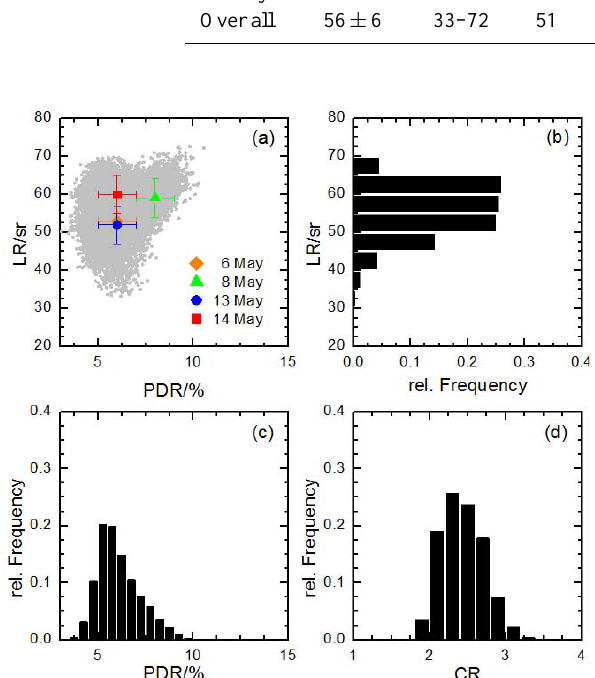
Fig. 8. (a) Scatterplot of lidar ratio (LR) vs. particle linear depo- larisation ratio (PDR) (both at 532nm) for measurements within pollution aerosol layers during the first half of the EUCAARI- LONGREX campaign. The grey dots show all lidar measurement points within pollution layers, the colour-coded squares show the mean values within the pollution layers for the different measure- ment days summarized in Table 2. (b) and (c) show the frequency distribution of the lidar ratio (LR) and the particle linear depolarisa- tion ratio (PDR) at 532nm, respectively, for all considered measure- ments during the first half of the EUCAARI-LONGREX campaign. (d) Frequency distribution of the colour ratio (CR) for all considered measurements during the first half of the EUCAARI-LONGREX